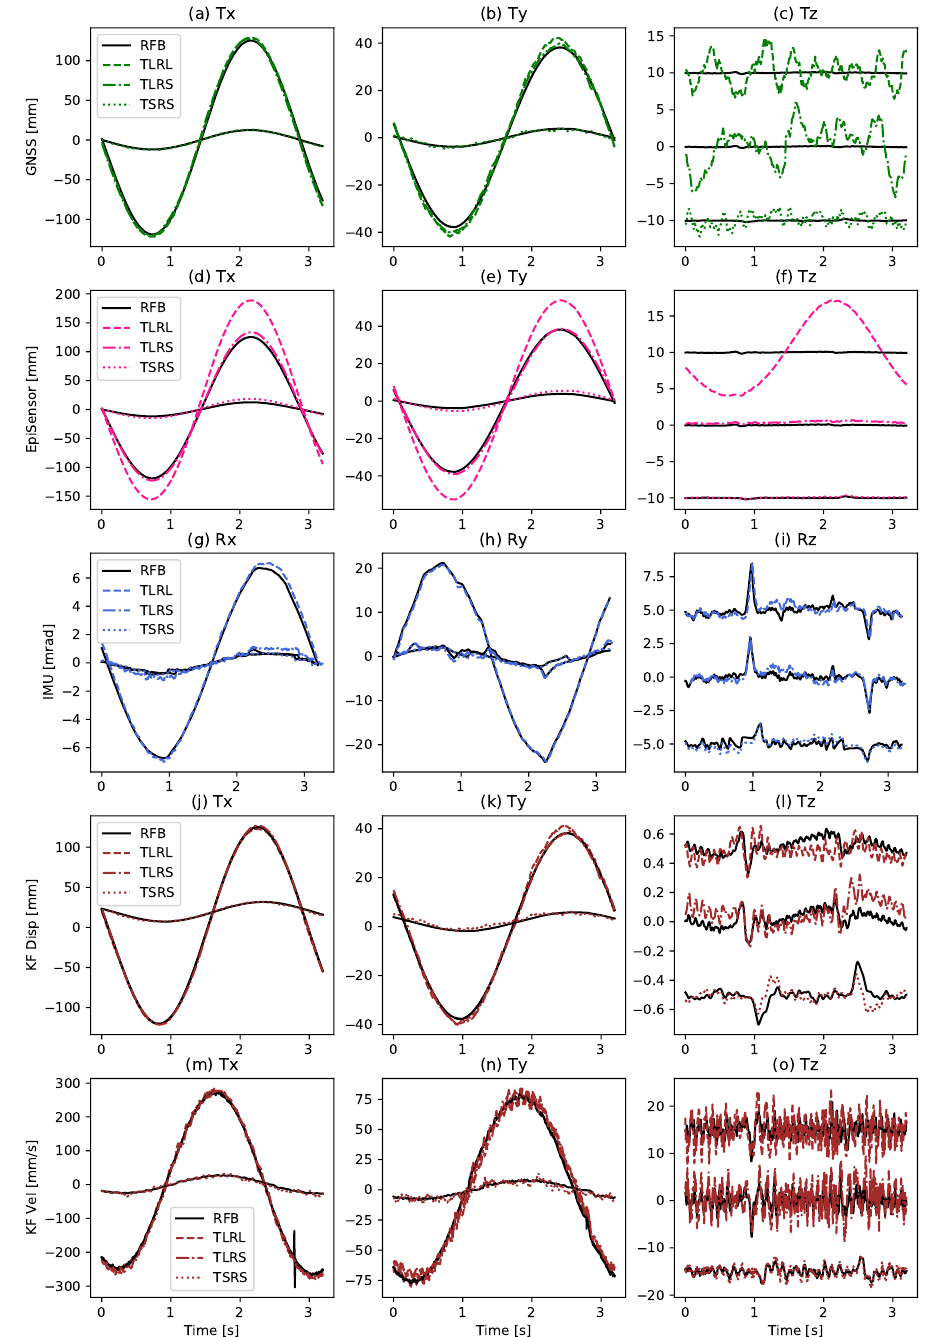
Figure 9. A summary of instrument (top three) and KF (bottom two) performance using time series. Each row of subfigures shows a 3 s zoom-in at 300 s of the simulated wind turbine tower with the recorded robot feedback (RFB) in black and additionally an instrument ( a – i ) or the KF estimated quantity ( j – o ) in color. All three experiments TLRL, TLRS and TSRS are shown per subfigure. ( a – c ) shows the GNSS data, ( d – f ) the EpiSensor data, ( g – i ) the IMU data, ( j – l ) the KF displacement estimates, and ( m – o ) the KF velocity estimates. The data have been high-pass filtered with a corner frequency of 0.08 Hz. Tz of each experiment was manually shifted for better visibility. Figure 9j–l indicate the KF displacement estimates. The sine waves are very smooth in Tx and in Ty, but, nonetheless, coincide well with the RFB. The large overshoot of the EpiSensor and the minor overshoot of the GNSS positions have been filtered out, leaving